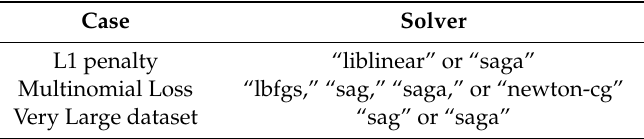
Table 3. Appropriate solvers for each